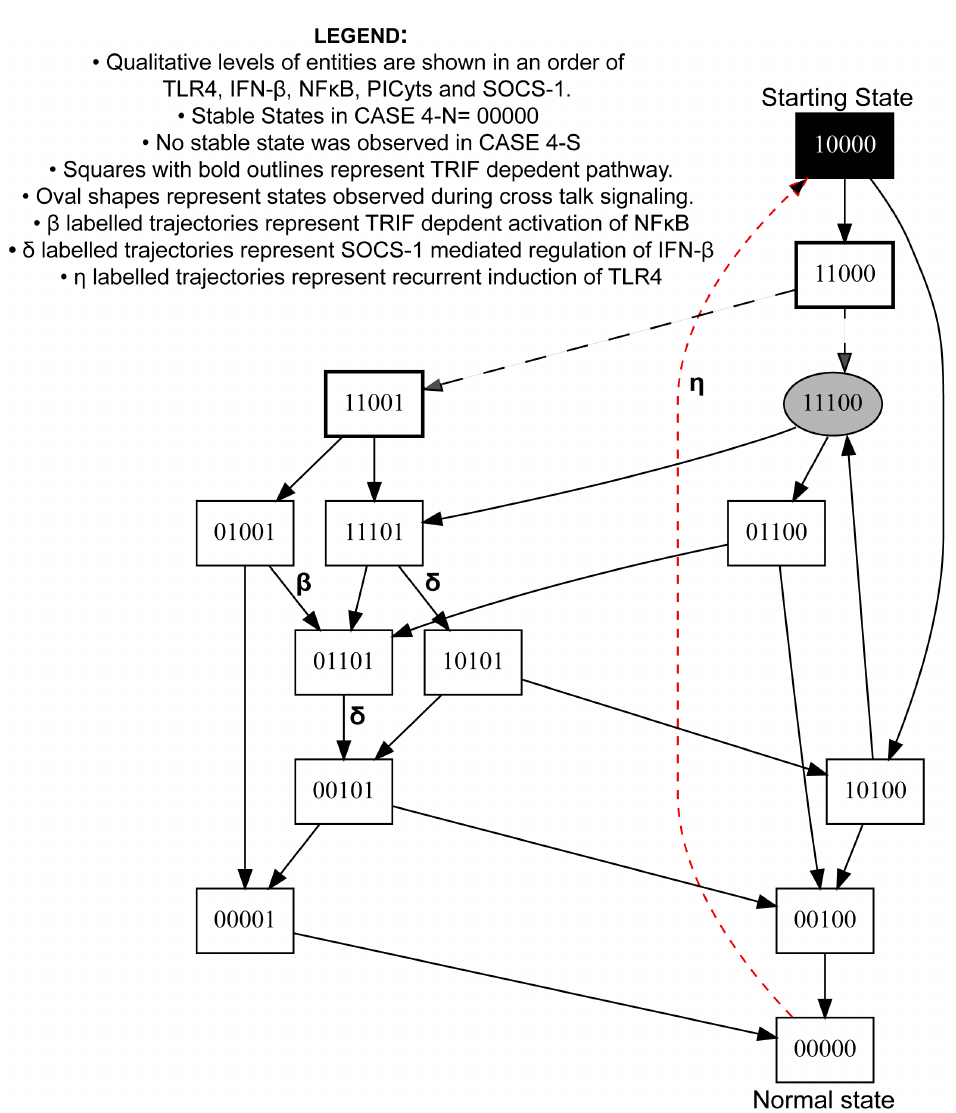
Figure 7. State graph of CASE 4-N and 4-S. Each node represents a particular state observed during signalling associated with CASE 4-N and CASE 4-S. Values ‘‘0’’ and ‘‘1’’ within the nodes represent qualitative levels of proteins in the order of TLR4, IFN- b , NF k B, PICyts and SOCS-1. Inactive entities are represented by integer ‘‘0’’ whereas active entities are represented by integer ‘‘1’’. Trajectories, which were specifically observed during signalling dynamics associated with CASE 4-S, are shown in red, whereas common states and trajectories found in both CASES are shown in black. Trajectories start from state ‘‘10000’’, representing the activation of TLR4, ultimately, lead towards ‘‘00000’’, which is a stable state in CASE 4-N. On the other hand, a trajectory labelled with ‘‘ g ’’ from state ‘‘00000’’ to starting state ‘‘10000’’ results in a cyclic path during signalling dynamics associated with CASE 4-S. State ‘‘00121’’ which represents the immune response was absent in state graph and not shown in this figure. MyD88 and TRIF dependent signalling are shown as black lines and dashed arrows, respectively. Nodes, which represent crosstalk of both signalling pathways i.e. IFN- b and NF k B with qualitative level ‘‘1’’ are presented in oval shapes. Arrows labelled with Greek small letters are used to represent trajectories associated with different signalling events (see legend in the figure). The conditions necessary to produce a state graph shown in the figure are given in Table 3.